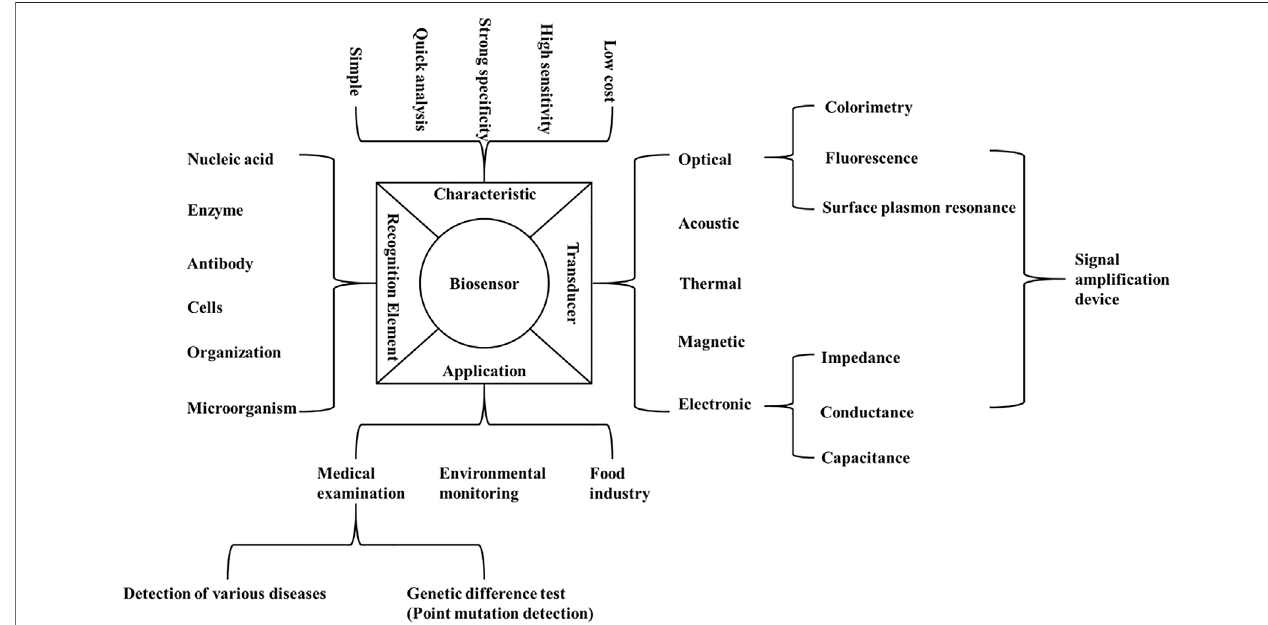
FIGURE 1 | Composition, characteristics and application of biosensor. The fi gure summarizes the characteristics, recognition elements, applications and transducers of the biosensors which can be used for the detection of point mutations.